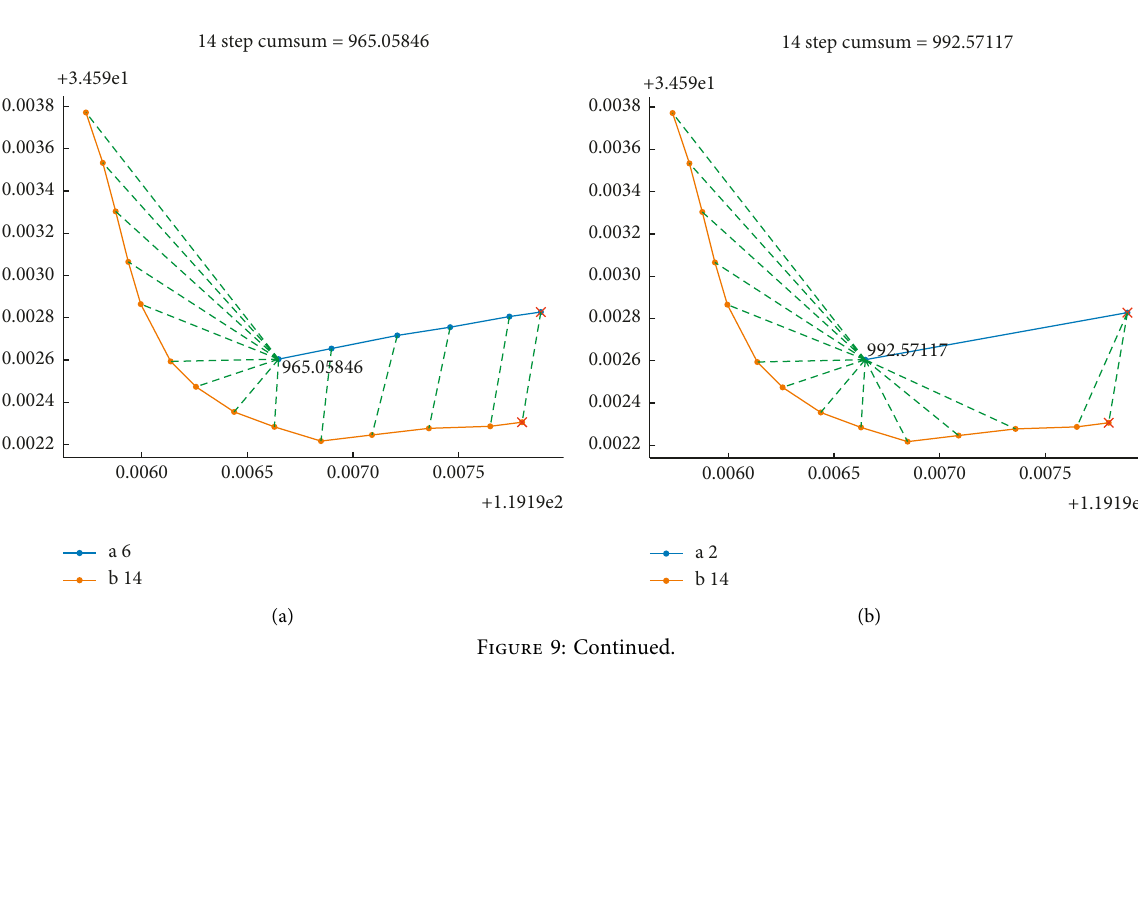
Figure 8: Comparison of DTW with different n-step continuity. (a) 3-step continuity for trajectory a. (b) 5-step continuity for trajectory a. (c) 7-step continuity for trajectory